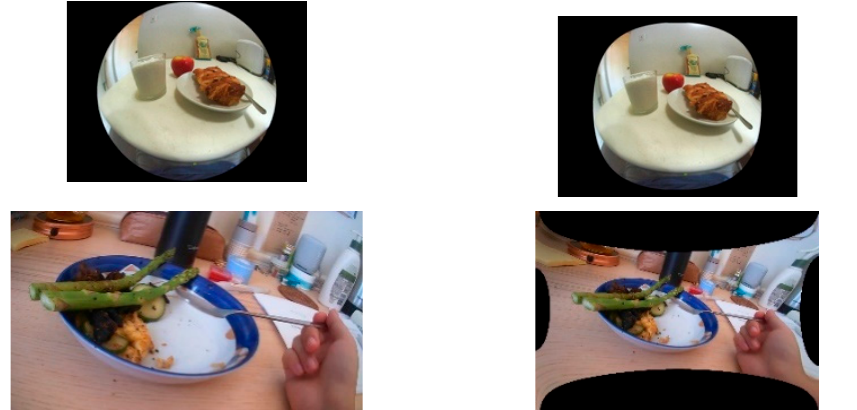
Figure 3. Inputs ( left ) and undistortion results ( right ). Top row : Circular image; Bottom row : Rectangular image. Rectangular